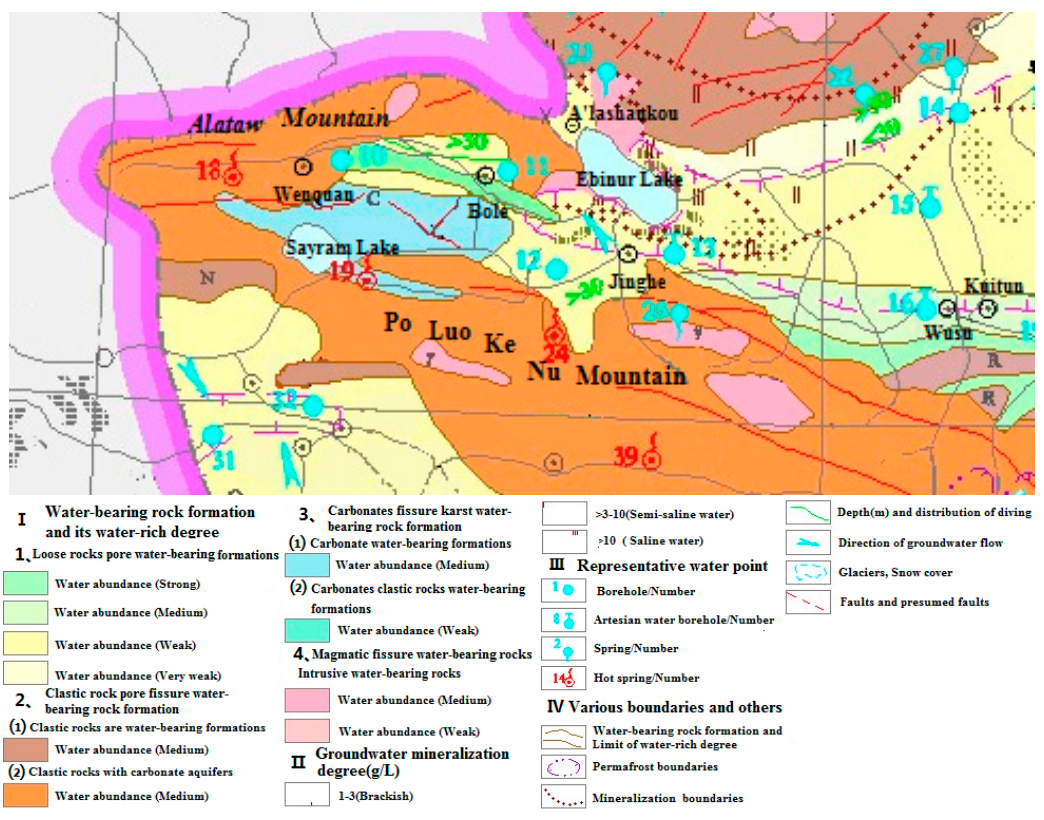
Figure 2. Hydrogeological map of the study area (this figure is modified from the hydrogeological map of Xinjiang).